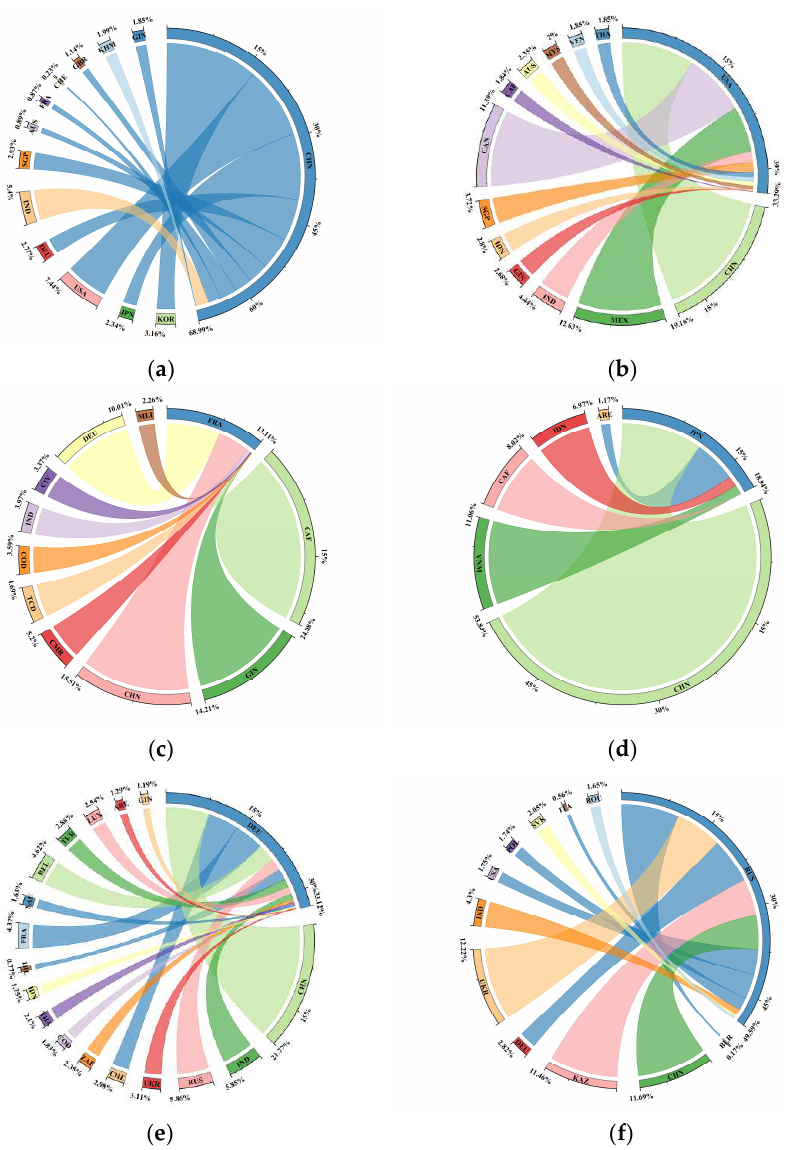
Figure 3. Embodied carbon transfers of major economies. (( a ): China; ( b ): United States; ( c ): France; ( d ): Japan; ( e ): German; ( f ): Russia).